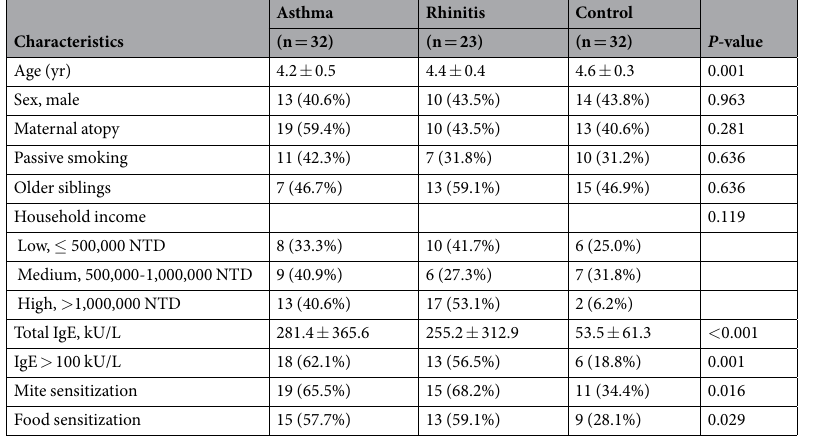
Table 1. Epidemiologic characteristics of the 87 children investigated in this study. Data shown are mean ± SD or number (%) of patients as appropriate. yr, year; NTD, New Taiwan Dollar; IgE, immunoglobulin